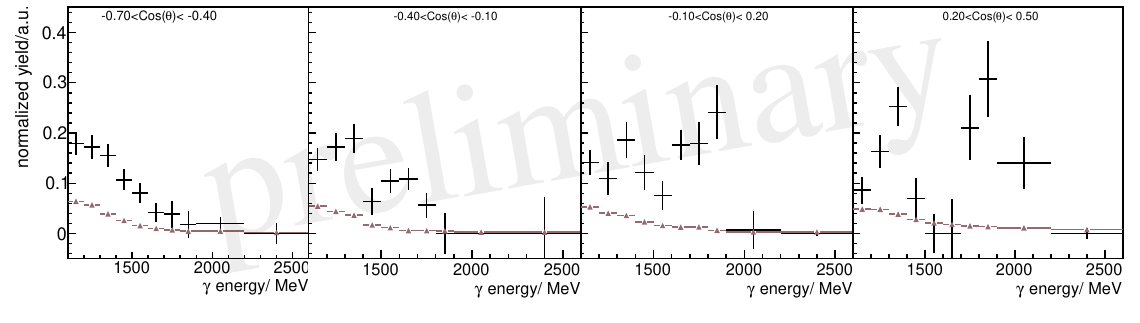
Figure 8. K 0 yield extracted from Roofit[8] (black points). Remaining K 0 Λ contribution, calculated from [9] (brown triangles). The error bars on the x-axis represent the bin width.